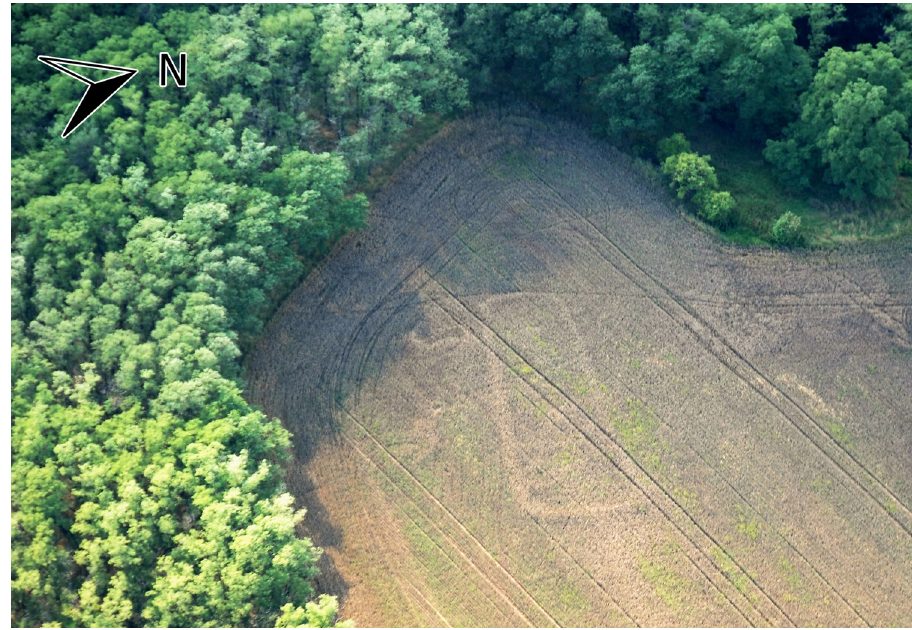
Figure 3: Vra ž kov ( Litom ěř ice district ) . Arial photograph of cropmark of a long barrow, the narrower end oriented to West ( after Gojda, 2019, Figure 5.129 )